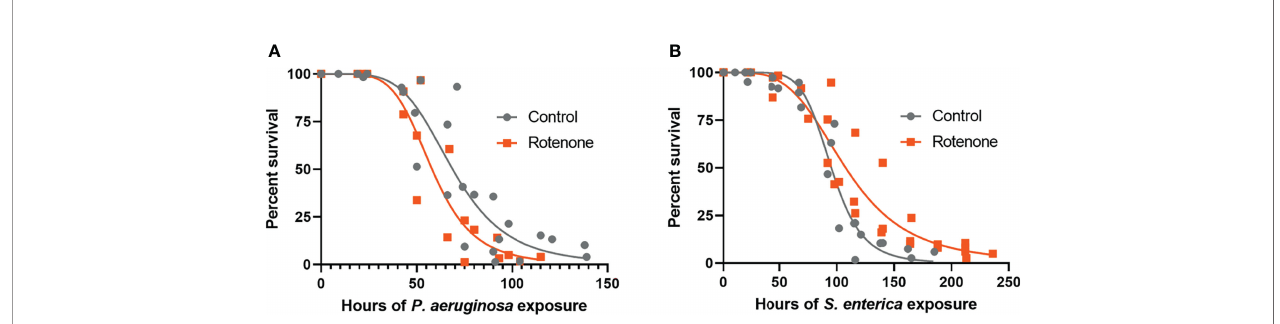
FIGURE 5 | Rotenone alters C. elegans pathogen susceptibility. Solvent control (Control) and rotenone-exposed nematodes (Rotenone) were further continuously exposed to (A) Pseudomonas aeruginosa (PA14) or (B) Salmonella enterica (SL1344) and scored for survival. Curves were fi t by nonlinear regression based on the results from three independent experiments for each pathogen exposure and represent a total of 148-197 animals scored (already excluding censored animals) per group. Details about the number of animals in each experiment and statistical results using the Mantel-Cox log-rank test are shown in Supplementary Table 1